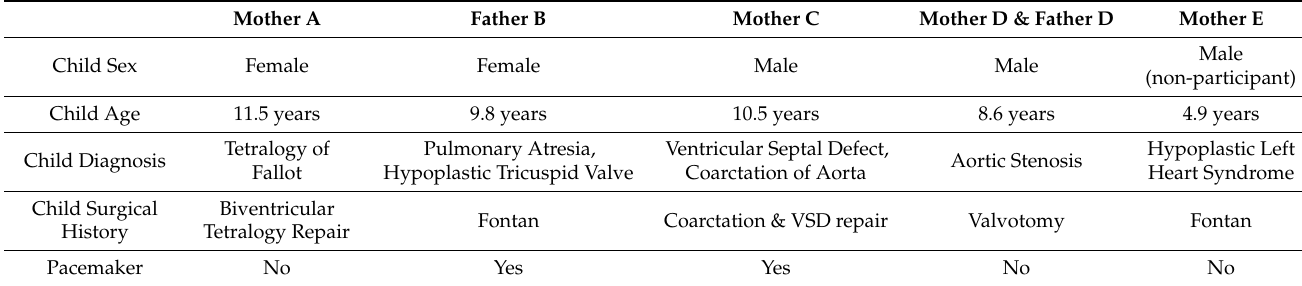
Table 1. Demographic Description of Participants Completing a Focus Group Only.